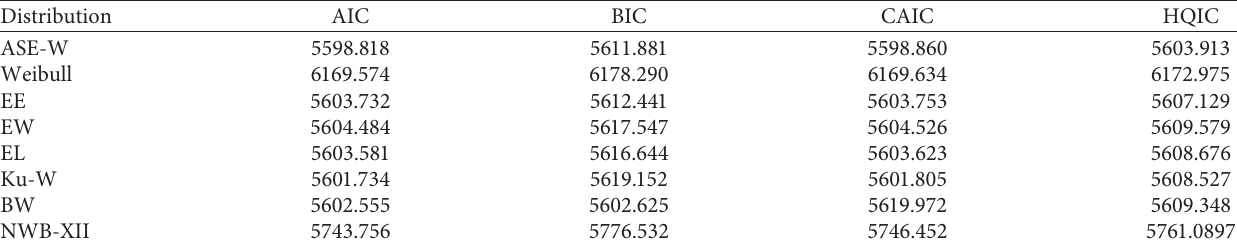
Table 8: Discrimination measures of the ASE-W model and other competing models.